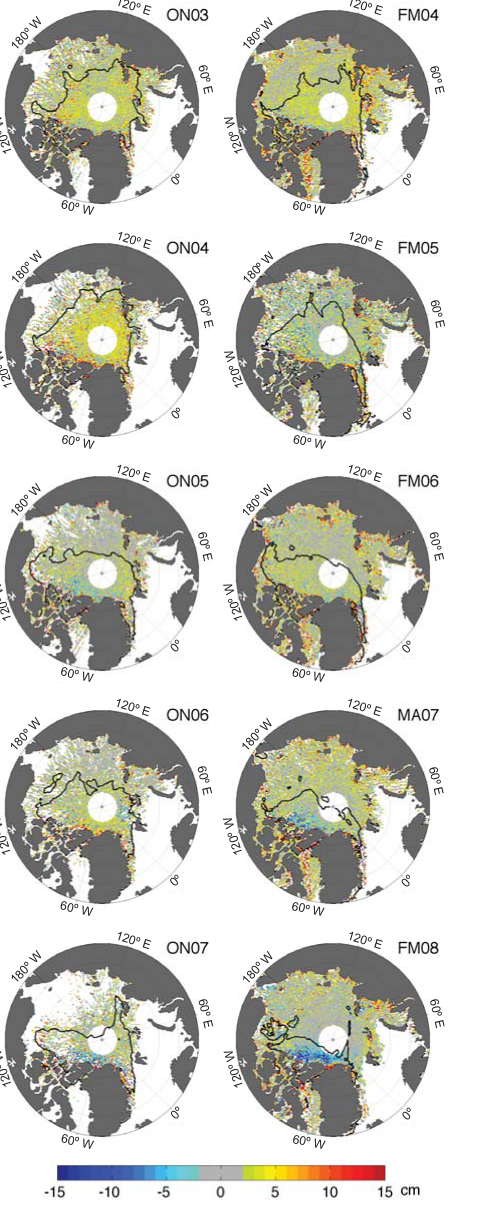
Figure 8. Maps (left) and distributions (right) of the differences between freeboard (25km grids) estimated using LLE and TP methods (LLE minus TP) for ten ICESat periods (cm). The TP method used here includes the improvements in the freeboard retrieval algorithm proposed in this study. Thick line on the maps delineates the 50% isopleth of multi-year ice